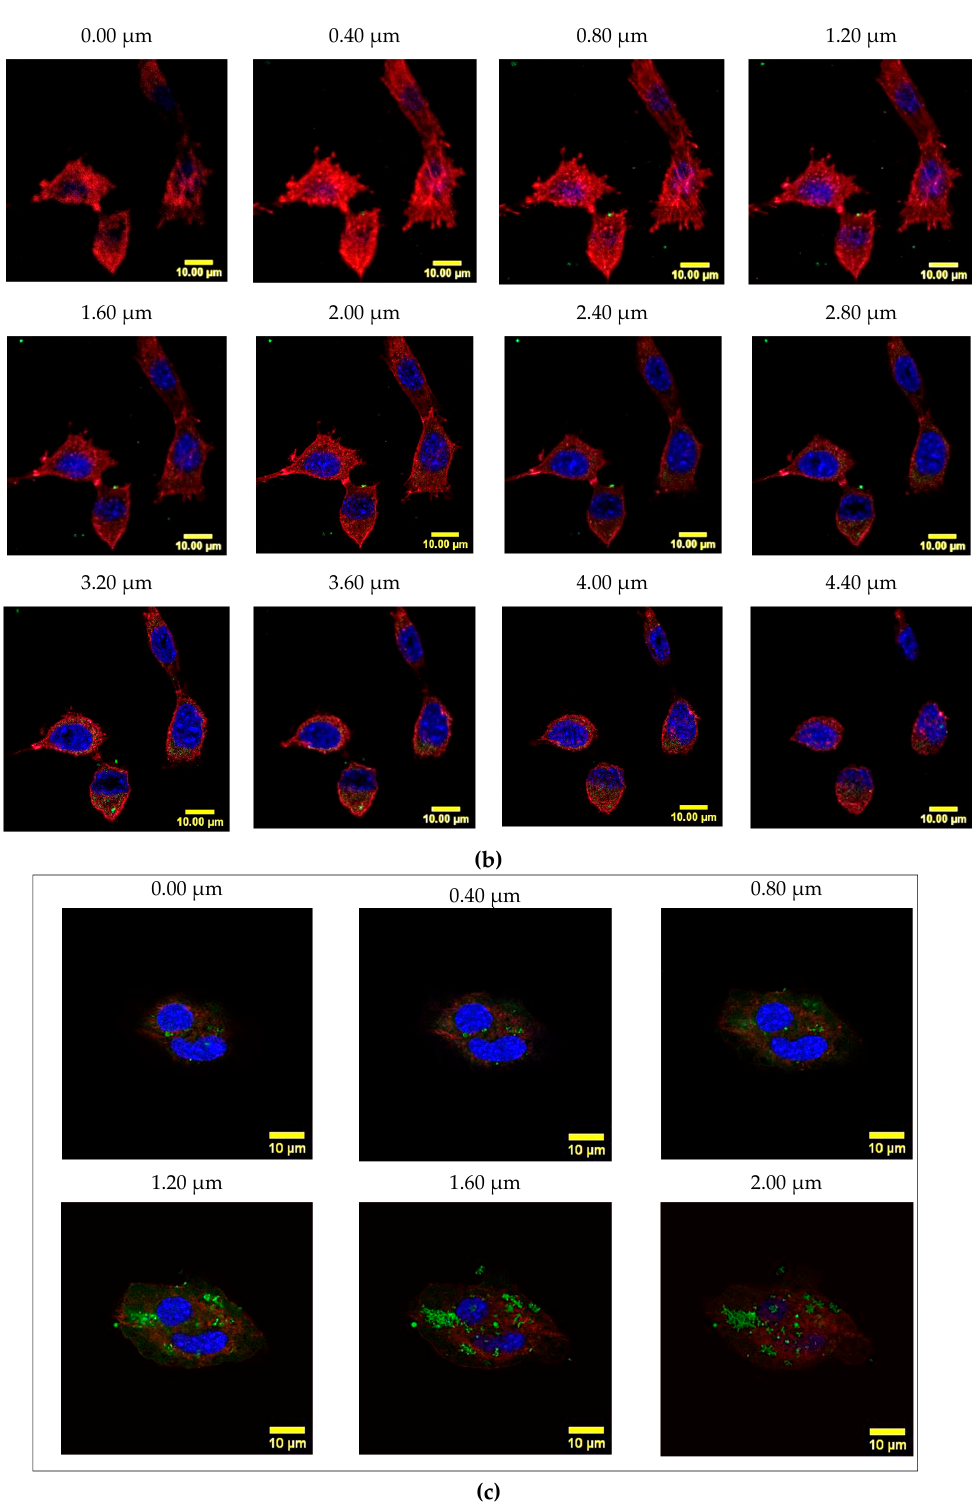
Figure 11. Internalization of FITC-labeled NP-253 and Cyt c-PEG-FA by LLC cells. ( a ) Confocal images of LLC cells treated with FITC-labeled Cyt c-PEG-FA and NP-253 (green) after 6 h incubation. The images shown in the lower panel are the co-localized pixels of FITC (green) and F-actin (red), which are shown in white. Nuclear stain DAPI is shown in blue. ( b ) Consecutive Z-stack images (cell bottom to top) of FITC-labeled Cyt c-PEG-FA (100 µ g / mL) treated LLC cells. ( c ) Consecutive Z-stack images (cell bottom to top) of FITC-labeled NP-253 (35 µ g / mL) treated LLC